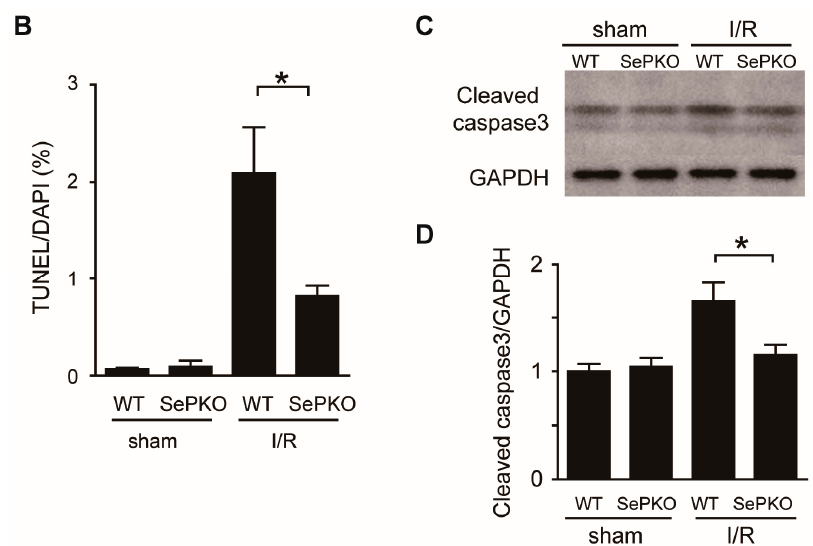
Figure 2. SeP KO mice reduces apoptotic cells after myocardial I/R. LV tissue sections were subjected to TUNEL and 4 ′ ,6-diamidino-2-phenylindole (DAPI) staining. ( A ) Representative examples of TUNEL-positive myocytes in the ischemic area. Arrows indicate TUNEL-positive myocytes. ( B ) The number of TUNEL-positive myocytes was expressed as a percentage of total nuclei detected using DAPI staining. Heart homogenates were prepared from SeP KO and WT mice subjected to 30 min of ischemia and 24 h of reperfusion. Immunoblot analyses were performed using ( C ) anti-cleaved caspase-3 and GAPDH antibody. ( D ) Results of quantitative analysis of cleaved caspase-3 are shown. Data represent means from at least five mice each. * p < 0.05.